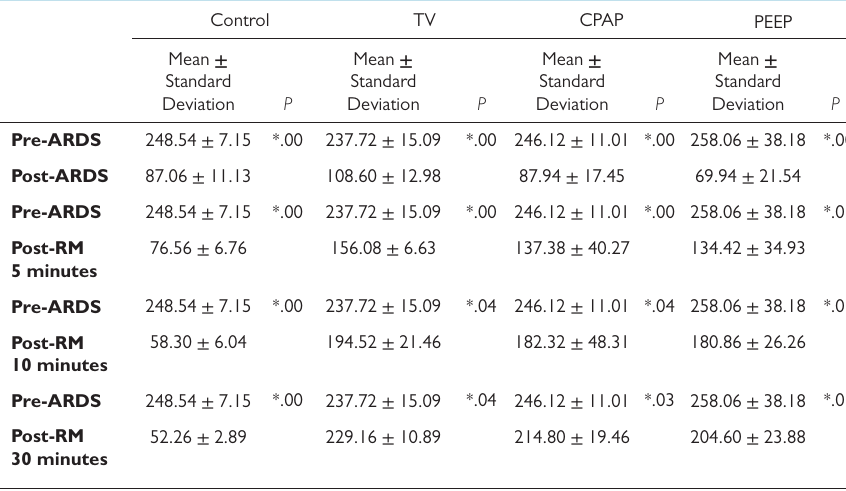
Table 1. PaO Values of the Groups Pre- and Post-ARDS 2 Control